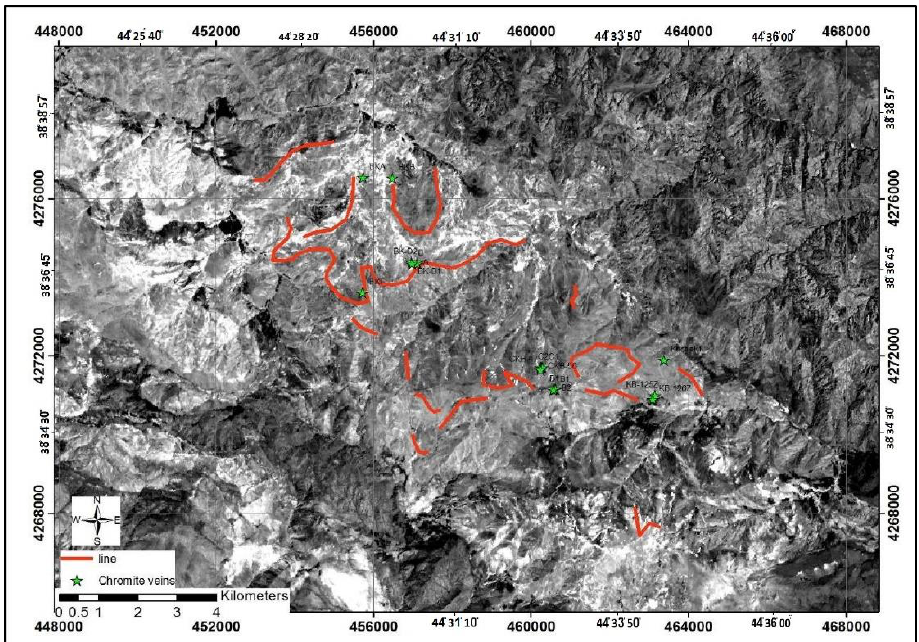
Figure 20. The most suitable geological traverse lines to continue prospecting in the Khoy ophiolite complex.